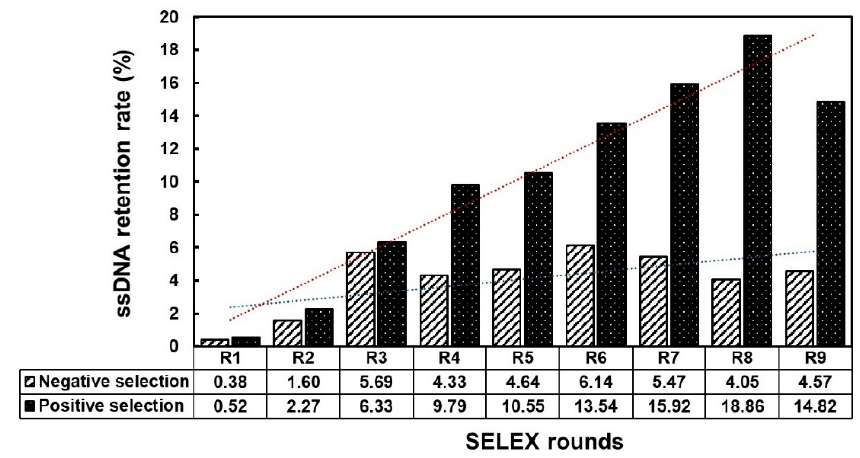
Figure 1. ssDNA retention rate of the selected ssDNA in the solution in each round of selection.